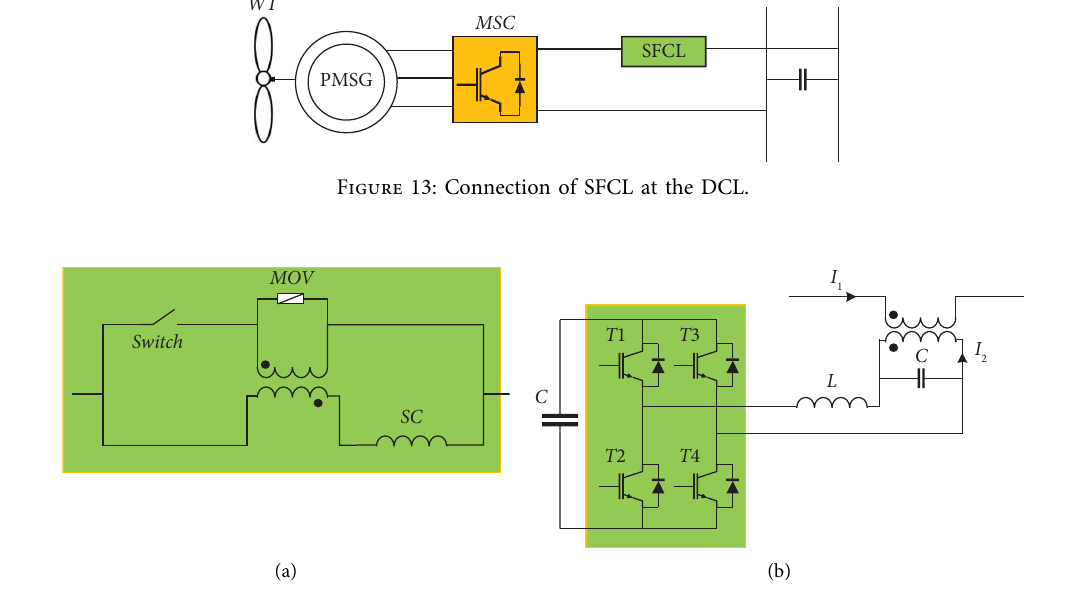
Figure 14: Confgurations of SFCL, (a) FC-SFCL, and (b) VCTA-SFCL. Table 4: Te performance comparison of presented SFCL